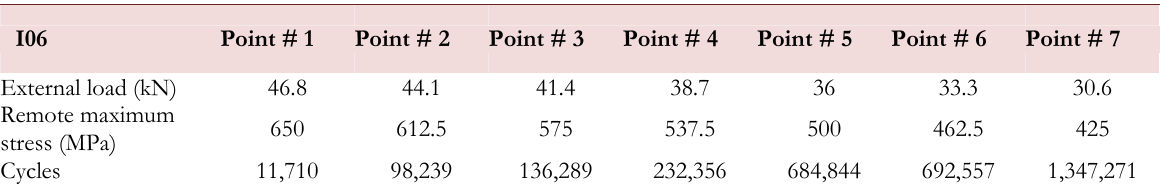
Table 2: Stress results for the I06 specimens.